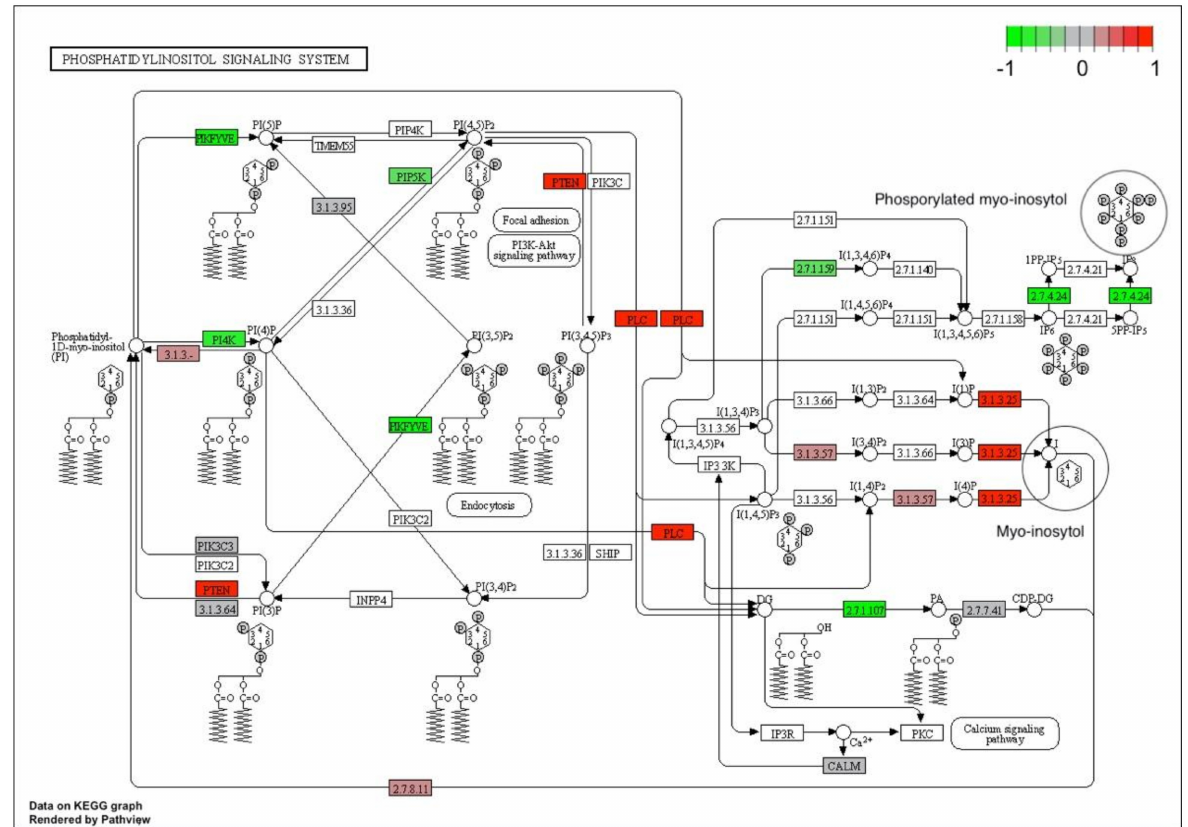
Figure 4. Putative transcripts involved in the phosphatidylinositol signaling pathway in guar based on homology with Arabidopsis thaliana on KEGG map obtained by Clusterprofiler (pathway ath04070) . The red-green scale is the mean value of log 2 fc. Green labels correspond to down-regulation in early flowering genotypes, red labels to up-regulated transcripts, grey labels to transcripts with no significant difference between conditions. The target metabolite is unphosphorylated myo-inositol marked by a